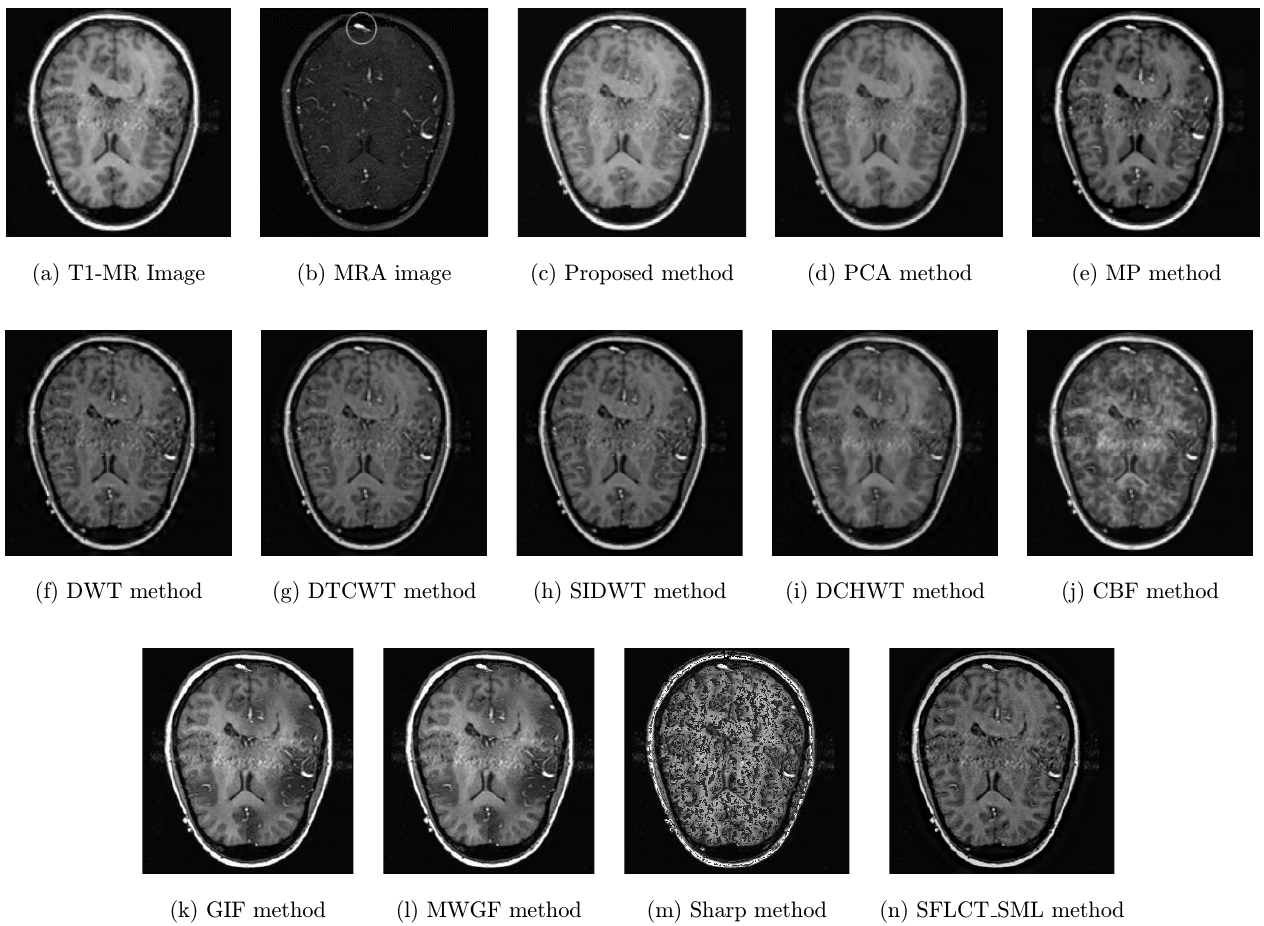
Fig. 5. Fused images for the second group of medical